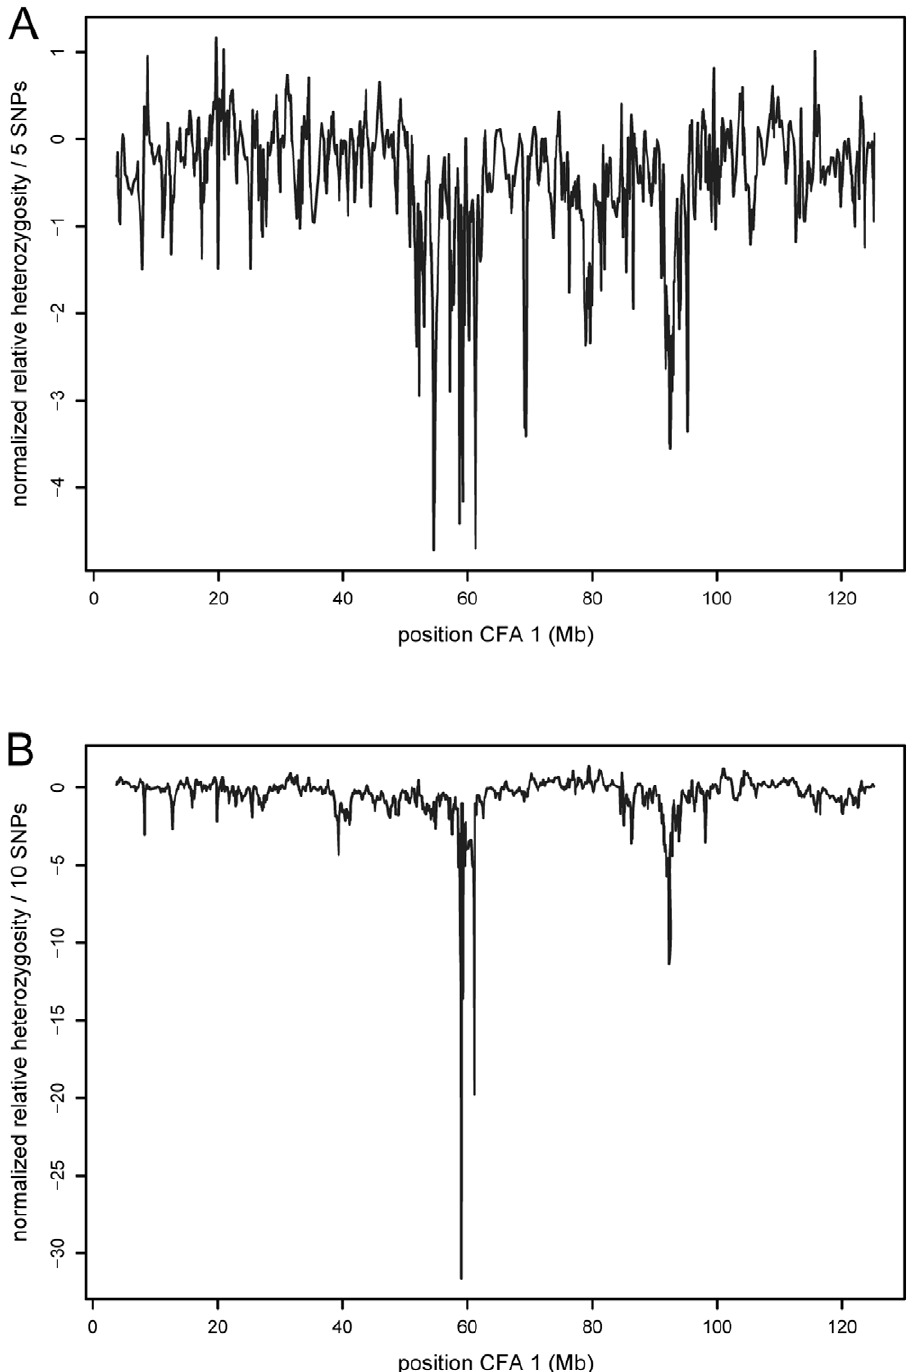
Figure 4. Normalized relative heterozygosity. A. Normalized relative heterozygosity (x axis) is plotted against position on CFA 1 in Mb (y axis) using a five SNP sliding window for brachycephaly in the original dataset. B. Normalized relative heterozygosity (x axis) is plotted against position on CFA 1 in Mb (y axis) using a 10 SNP sliding window for brachycephaly in the second independent dataset.